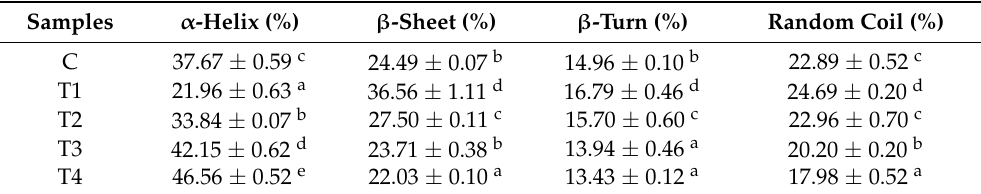
Table 7. Relative content of the secondary structure of proteins in the cooked pork batters prepared with various amounts of ORP.